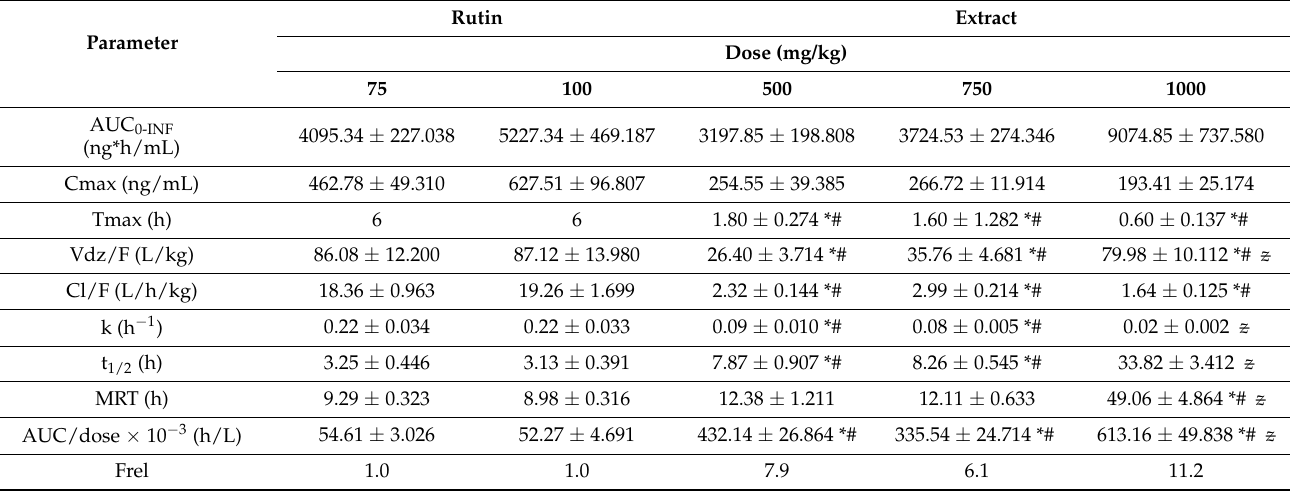
Table 3. Pharmacokinetic parameters from non-compartmental analysis of quercetin after oral administration of pure rutin and the extract of calyces of Physalis peruviana